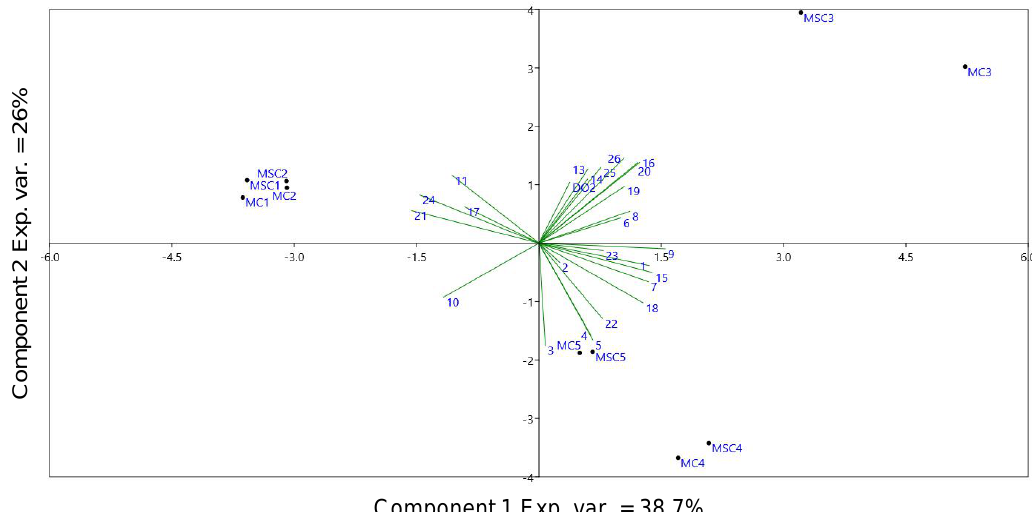
Figure 5. PC1 (exp. variance = 38.7%) vs. PC2 (exp. variance = 26%) model for Merlot wines. Volatile compound relative abundances and measured dissolved oxygen were used as variables. Volatile compounds labels ( 1 – 26 ) are explained in Table 4.